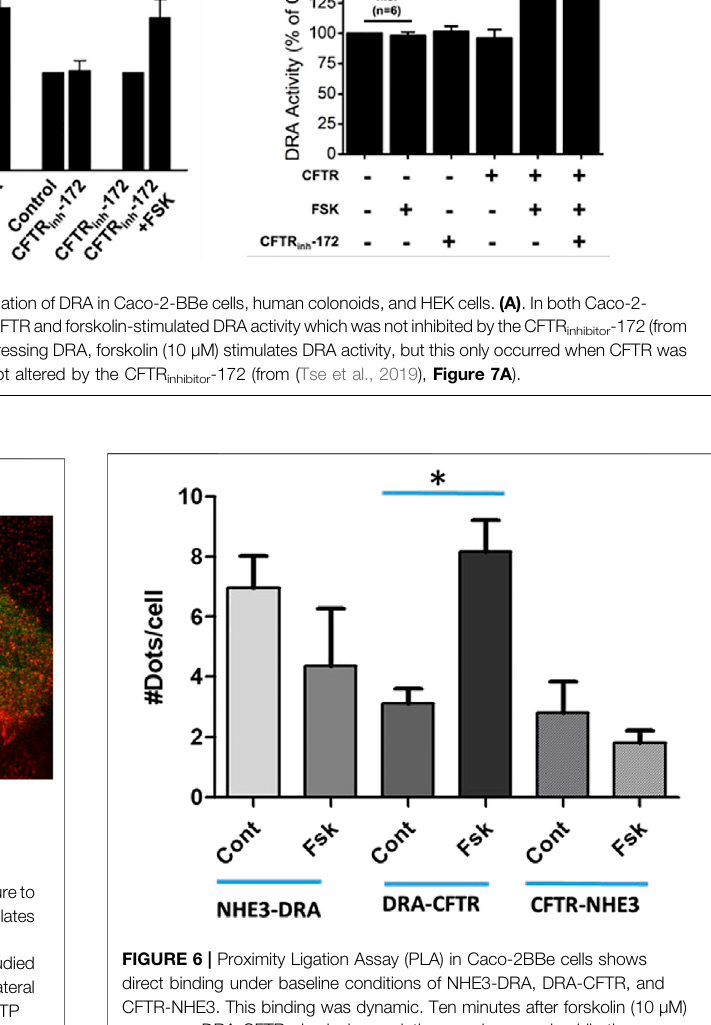
Frontiers in Physiology |